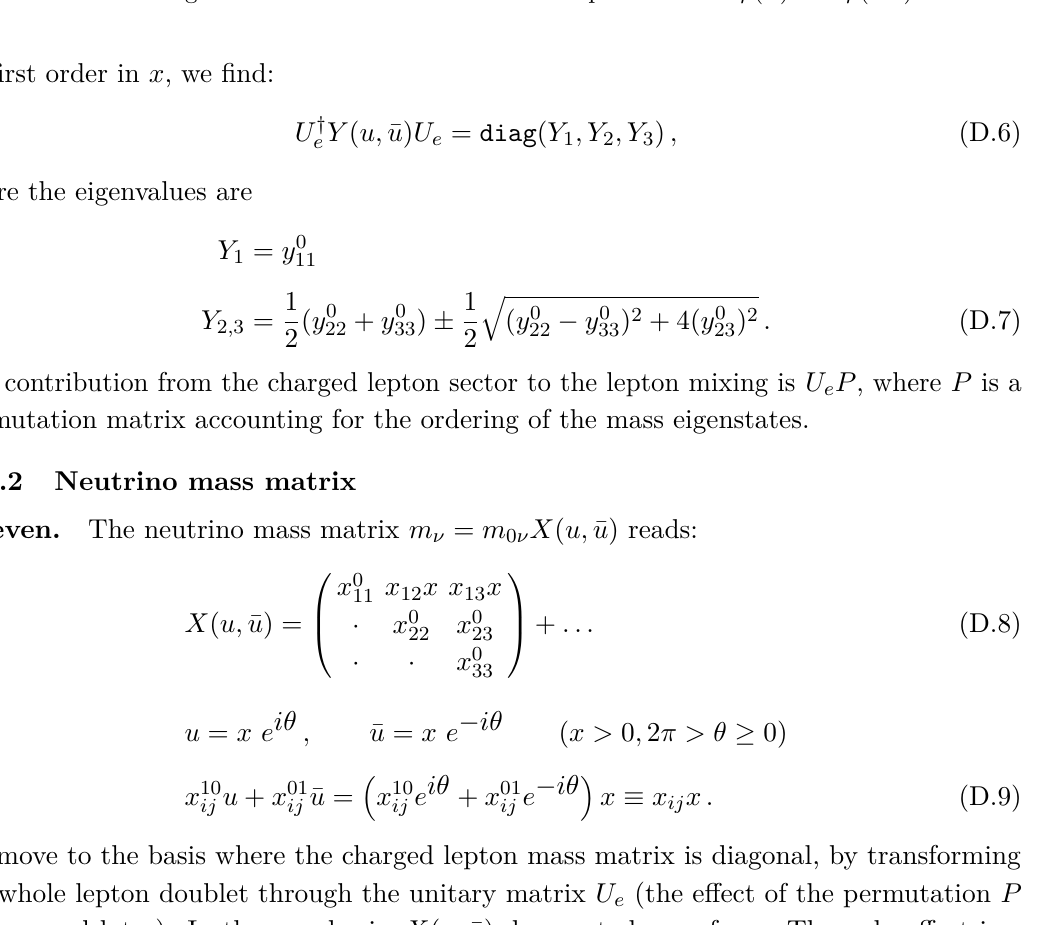
Table 9 . Eigenvalues of the three-dimensional representations ρ ( S ) and ρ ( ST )